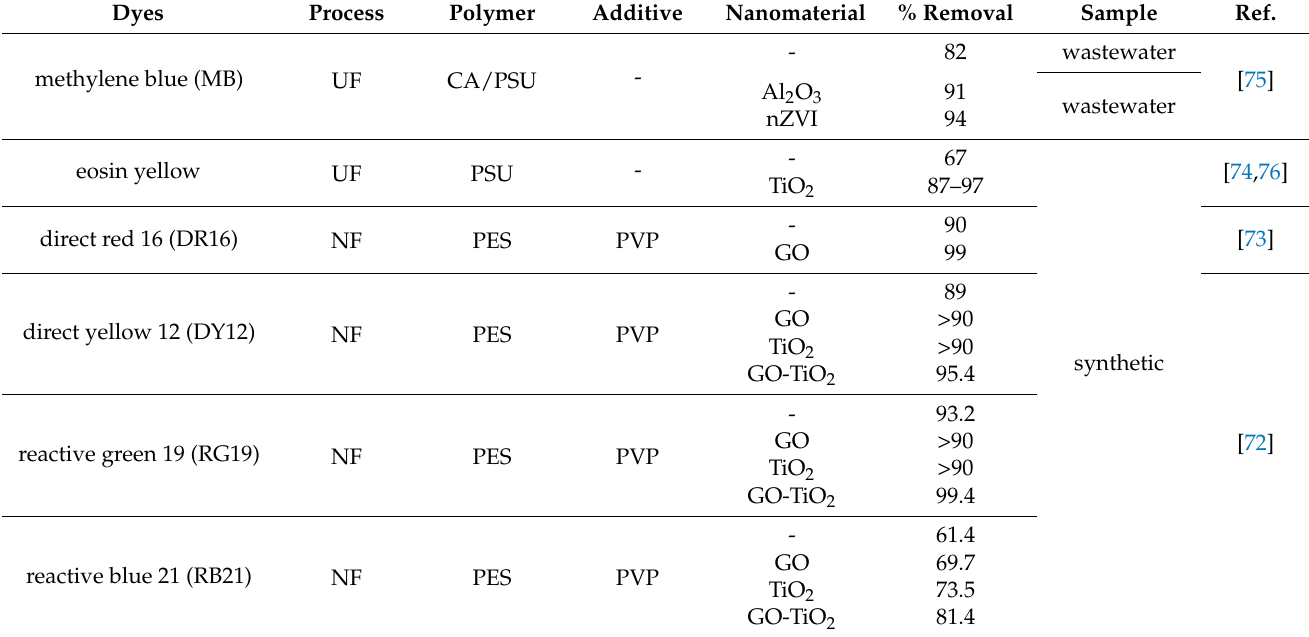
Table 4. Application of polymeric membranes in the purification of water contaminated with